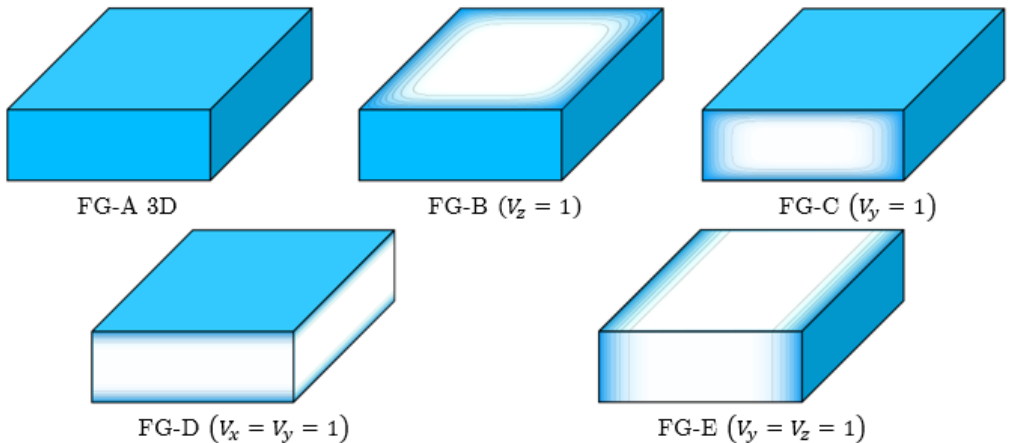
Figure 2. Five schemes of coated FG shell (𝑅 𝑥 = 𝑅 𝑦 = ∞) .